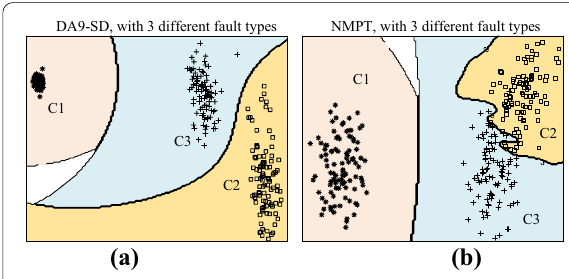
Figure 7 Classification hyperplane of DA9-SD: a Original DA9-SD; b After model parameter transfer